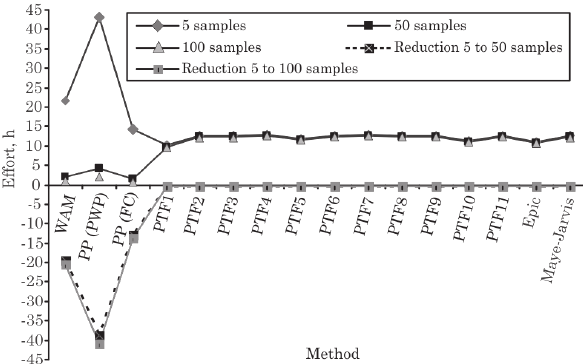
Figure 4. Effort per sample generated by the method and decrease in effort caused by the increase in the number of samples